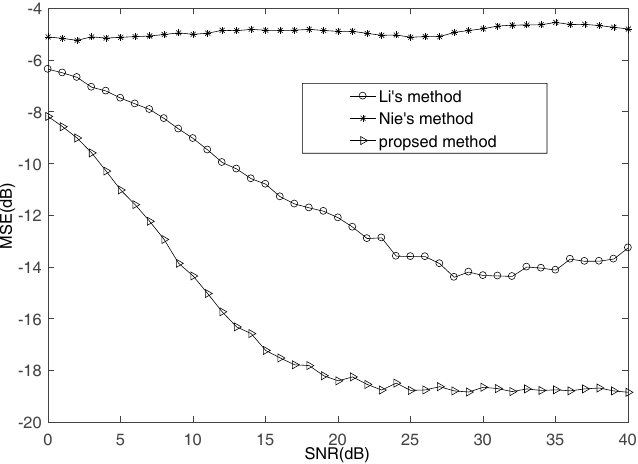
Figure 6. The MSE comparison of different methods for M = 4 and N =